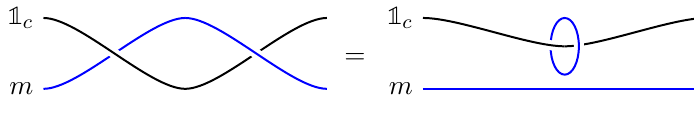
Figure 23. The double braiding of the 1 c -string and the m -string is z ⊗ 1 m